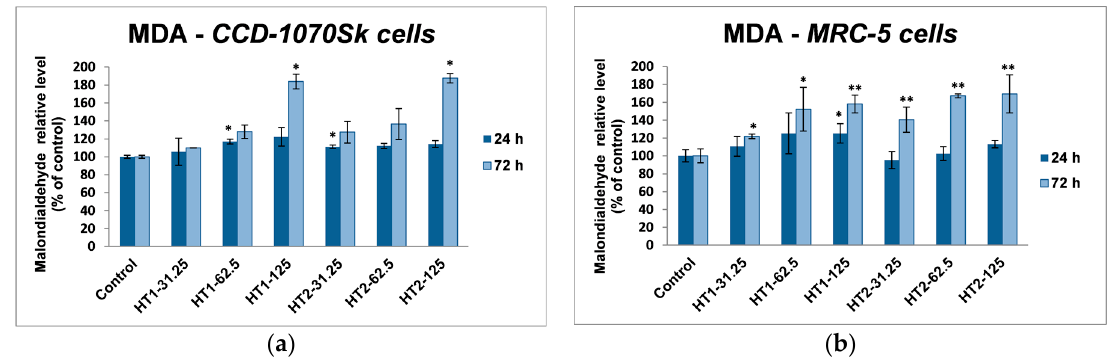
Figure 10. Malondialdehyde (MDA) levels in normal skin ( a ); and lung ( b ) fibroblasts exposed to different concentrations (31.25, 62.5, and 125 μ g/mL) of TiO 2 -1% Fe–N NPs co-precipitated at pH 8.5 (HT1) or 5.5 (HT2) for 24 h and 72 h. Results are expressed as the mean ± standard deviation (SD) ( n = 3) and represented relative to the untreated cells (control). * p < 0.05 and ** p < 0.01 compared to control.